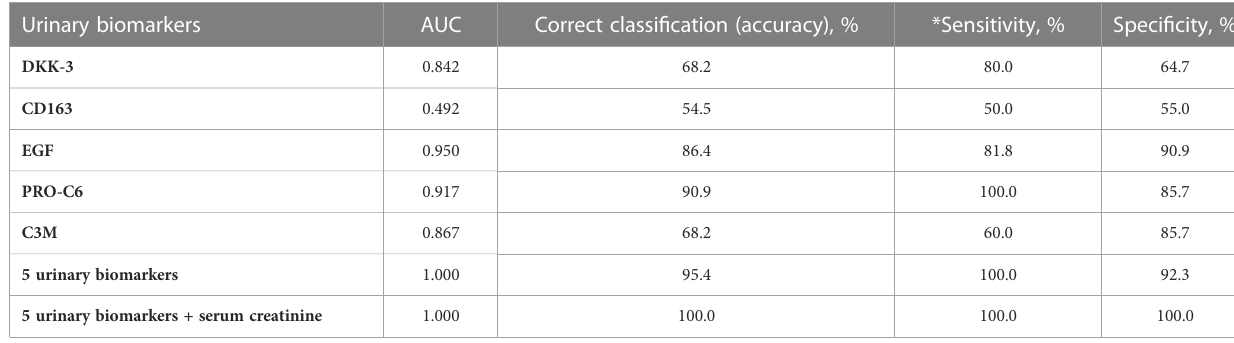
TABLE 4 AUC (from ROC), accuracy, sensitivity and speci fi city of the discrimination of Focal class from Sclerotic class with selected urinary biomarkers. Urinary